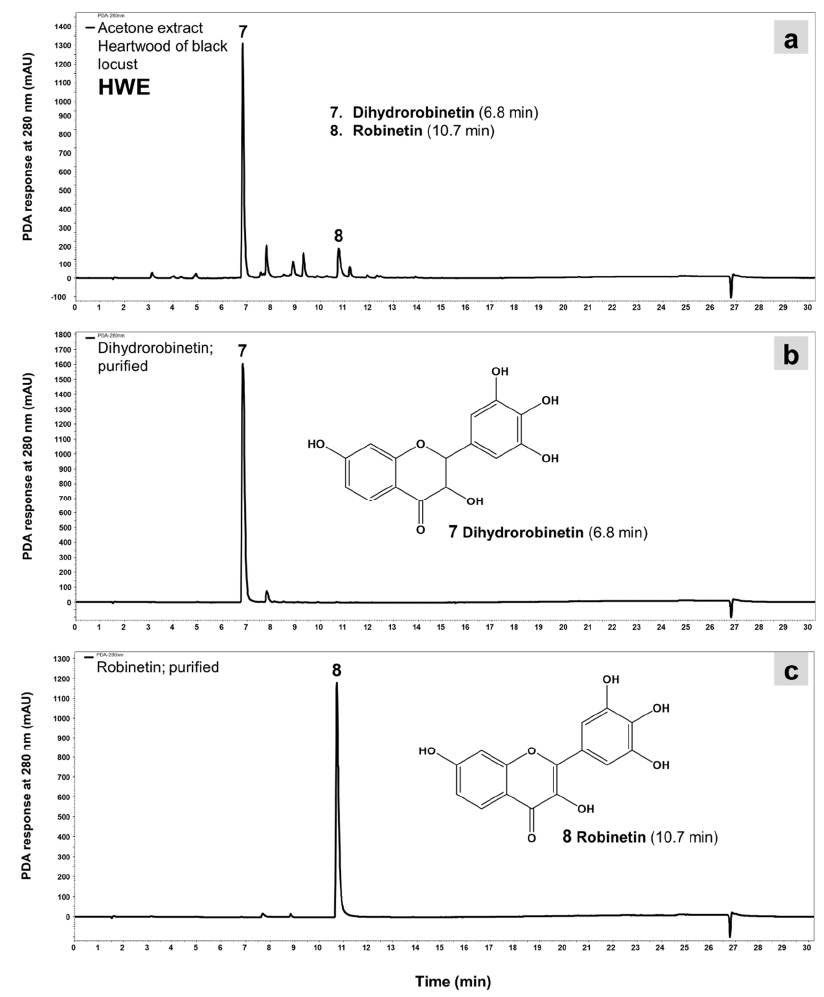
Figure 3. HPLC-PDA chromatograms of black locust ( Robinia pseudoacacia ). ( a ) Homogenized acetone extract of heartwood (HWE), ( b ) pure dihydrorobinetin (DHR) used for the antifungal assay and ( c ) pure robinetin (Rob) used for the antifungal assay.